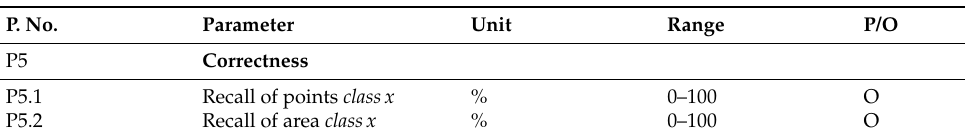
Table 9. Parameters for